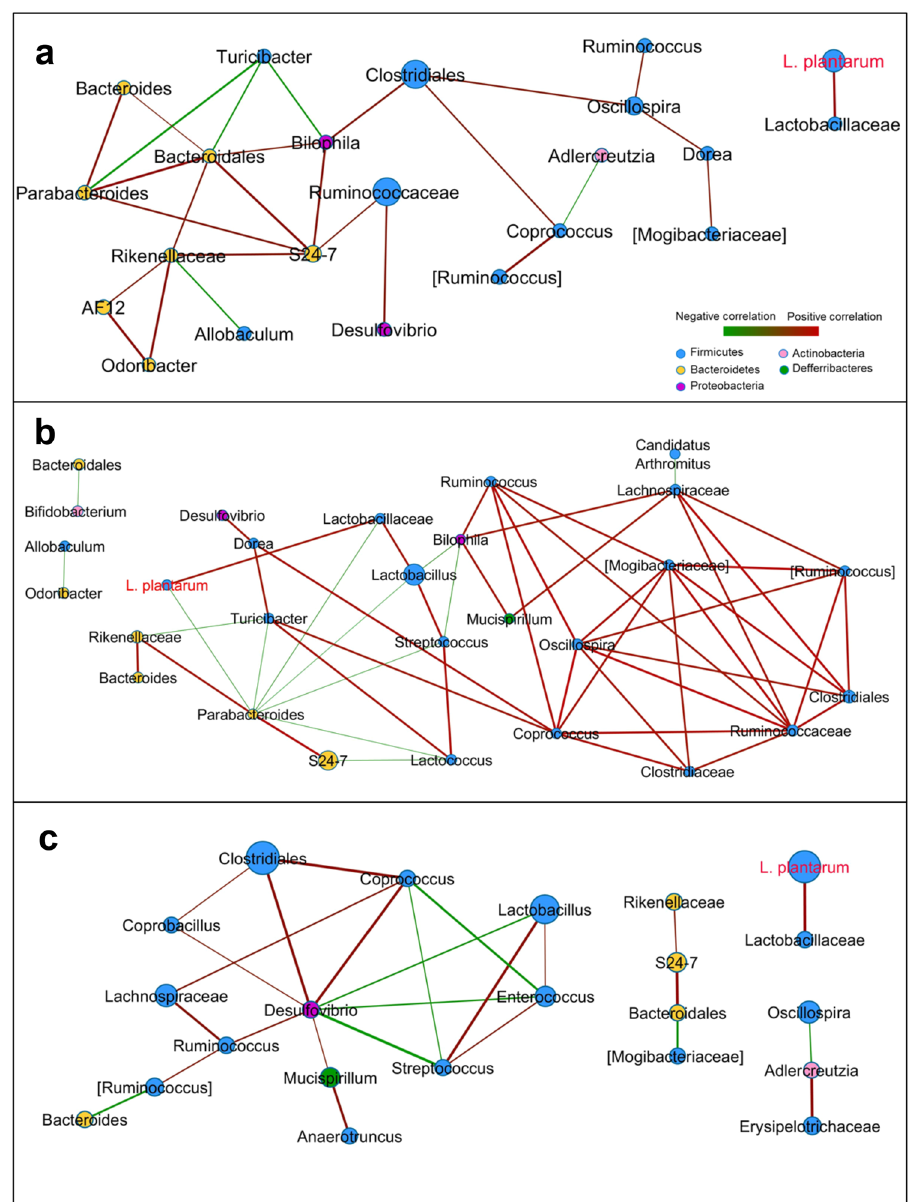
Figure 5. Network analysis showed various interactions among L . plantarum WCFS1-R, indigenous Lactobacillus and other gut microbes. Intestinal microbiota during L . plantarum WCFS1-R consumption on HFHSD1 (day 10, day 12) ( a ), LFPPD (day 24, day 26) ( b ) and HFHSD2 (day 38, day 39) ( c ) were analyzed. Each node represents one genus with the color indicating the phylum to which the genus belongs and the size of the node proportional to the relative abundance of that organism in the bacterial community (only taxa with the average abundance over 0.001 are shown). The line between nodes indicates the Spearman correlation and the color intensity indicates the correlation coefficient (red, positively correlated and green, negatively correlated). The weight of the line corresponds to the correlation significance. Taxa in brackets are based on annotations suggested by the Greengenes